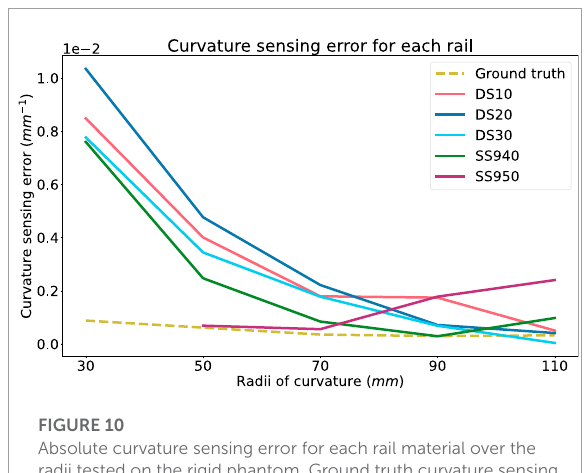
FIGURE 10 Absolute curvature sensing error for each rail material over the radii tested on the rigid phantom. Ground truth curvature sensing error is added as a baseline.